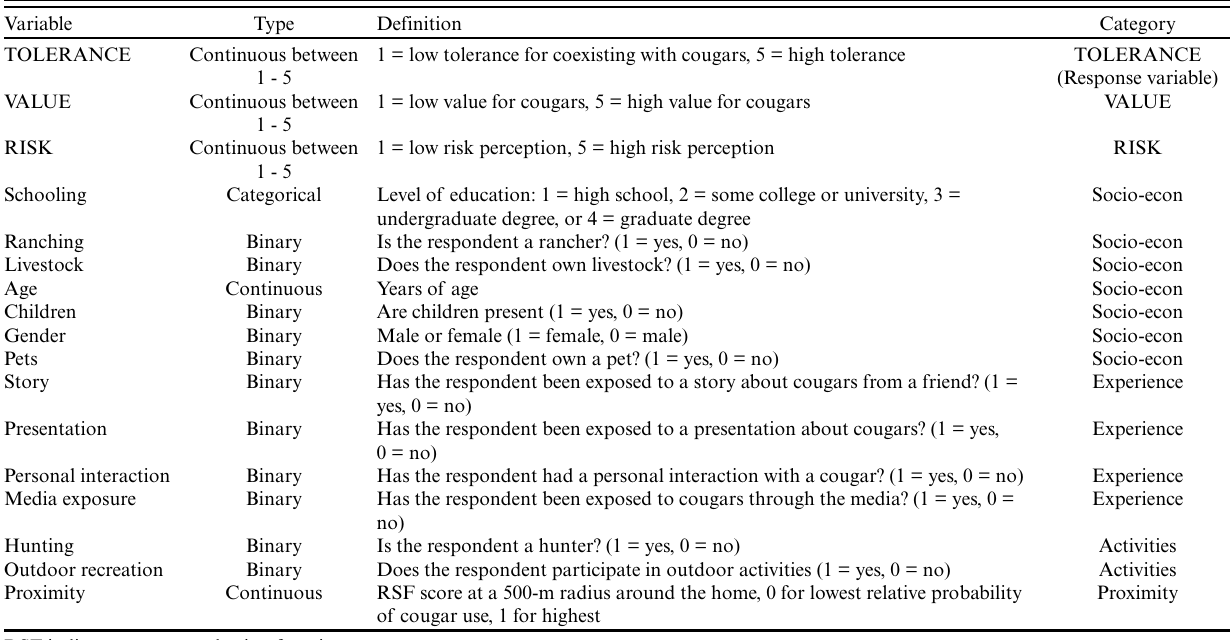
Table 1 . Definitions of variables used in questionnaire